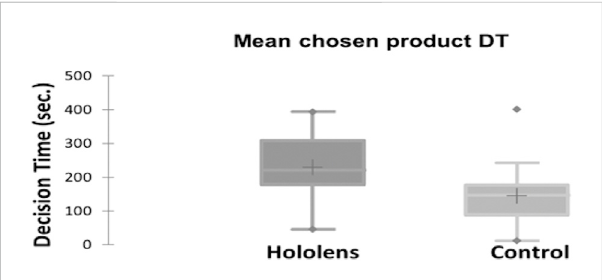
FIGURE 3 Differencesbetween groups indecision times relativeto product